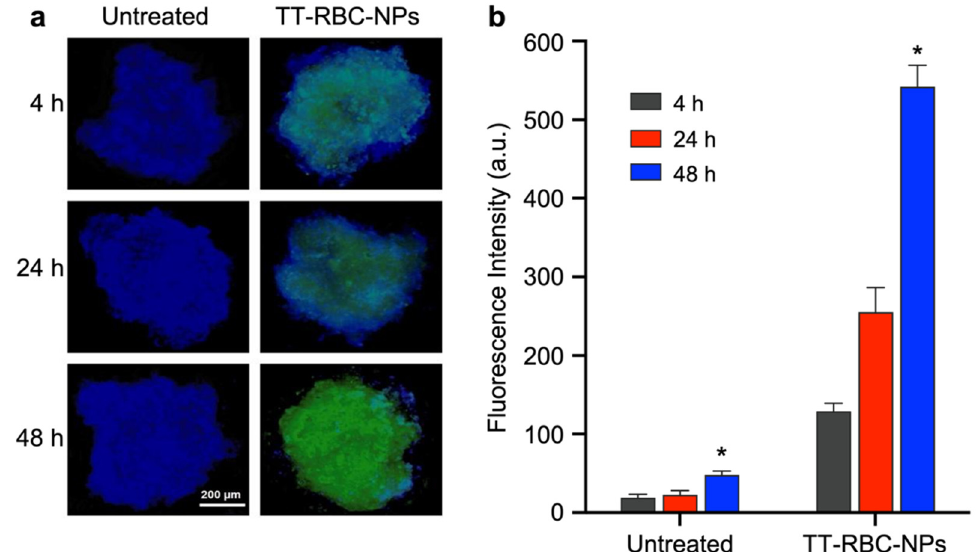
Figure 9. TT-RBC-NPs penetration in tumor spheroids. ( a ) Fluorescence images of MCF-7 (EpCAM+) spheroids with and without treated with TT-RBC-NPs (green channel). The nucleus was stained with DAPI (blue channel). Scale bar = 200 µ m. ( b ) Quantification of mean fluorescence intensities of TT-RBC-NPs on MCF-7 spheroids with incubation times of 4, 24 and 48 h. Bars represent mean ± SD ( n = 3). * the significance between Untreated and TT-RBC-NPs at 48 h incubation ( p < 0.05).